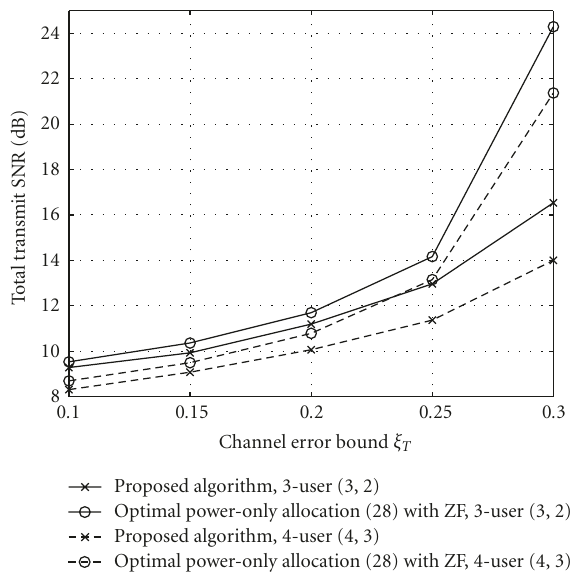
Figure 6: The total transmit SNR versus the channel error bound for 3-user (3,2) and 4-user (4,3)